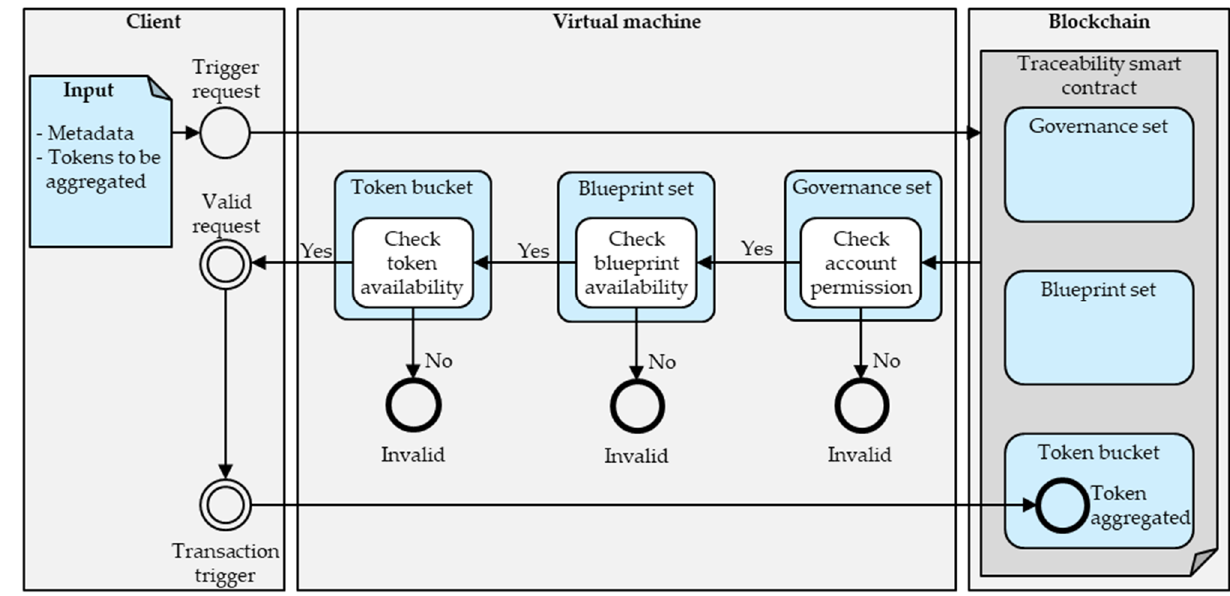
Figure 6. Request and transaction flow for aggregating tokens.